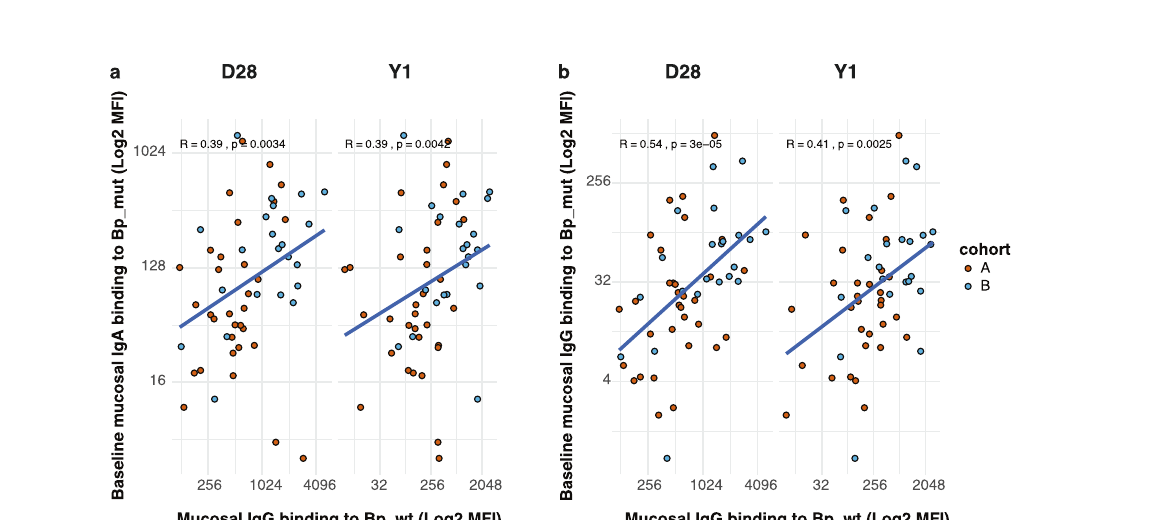
95% con fi dence intervals (solid black point and line) are plotted. Data are N =32 individuals for cohortA and N =22individuals for cohort B. Anunpaired two-sided Kruskal – Wallis followed by Wilcoxon rank-sum test was used to compare across cohorts.